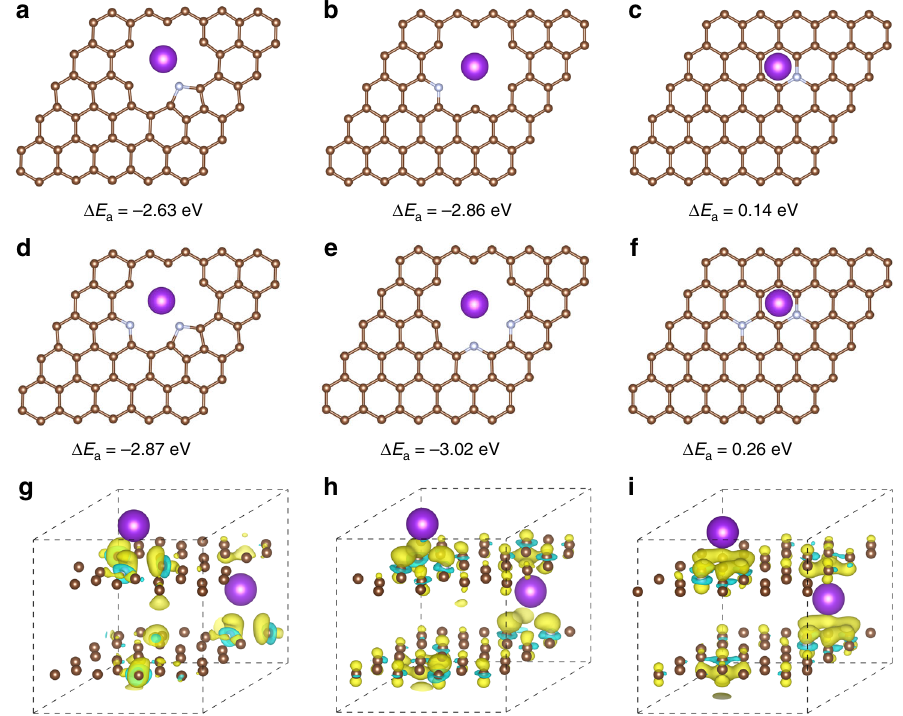
Fig. 6 Theoretical simulations of K-adsorption in different N-doped structures. Top view of a single K atom adsorbed in the N-5 ( a ), N-6 ( b ), and N-Q ( c ) structures and the corresponding adsorption energy. Top view of a single K atom adsorbed in the doped structures with two nitrogen atoms and the corresponding adsorption energy: d one N-5 and one N-6 atoms; e two N-6 atoms; f two N-Q atoms. Electron density differences of K absorbed in the N-5 ( g ), N-6 ( h ), and N-Q ( i ) structures. Yellow and blue areas represent increased and decreased electron density, respectively. The isosurfaces are the 0.0015 electron bohr 3 . Brown, silver, and purple balls represent carbon, nitrogen, and potassium atoms,